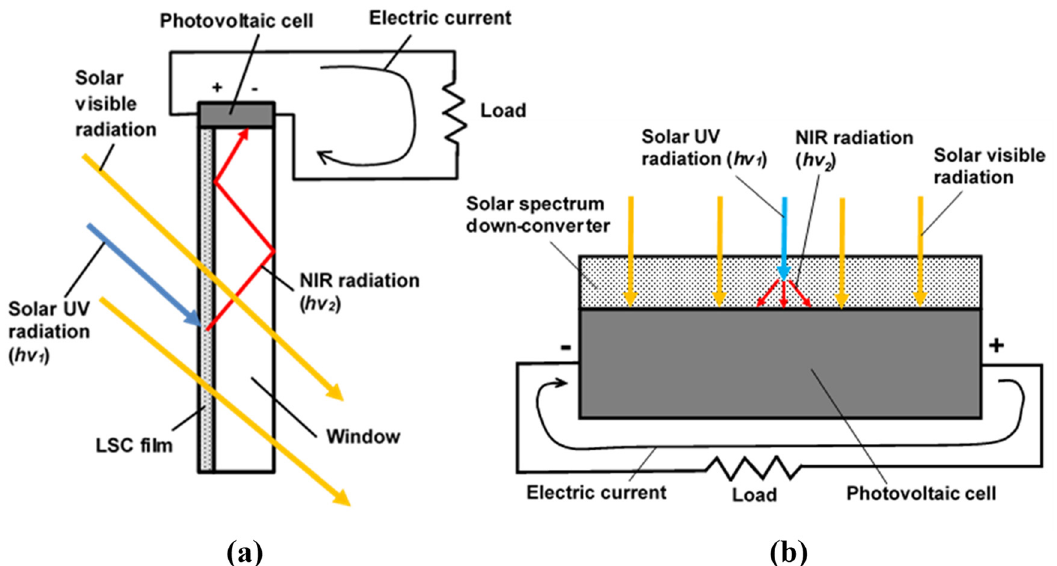
Figure 1: ( a ) The concept of LSC. The nanoparticles of a luminescent material in the nanocomposite coating absorb incident UV/blue sunlight ( blue arrows; photons with energy h ν h is Planck ’ s constant and ν ) and re - emit at an NIR 1 , where 1 is the frequency of UV/blue radiation wavelength ( red arrows; photons with energy h ν 2 , where ν 2 is the frequency of NIR radiation ) in glass window guiding it to a PV cell attached to the edge. ( b ) The concept of sunlight spectrum down - convertor over a PV cell. A down - converting fi lm over a conventional PV cell absorbs incident UV/blue sunlight and down - converts it into NIR radiation that e ffi ciently generates extra PV power in addition to the one produced by visible and NIR spectral components of